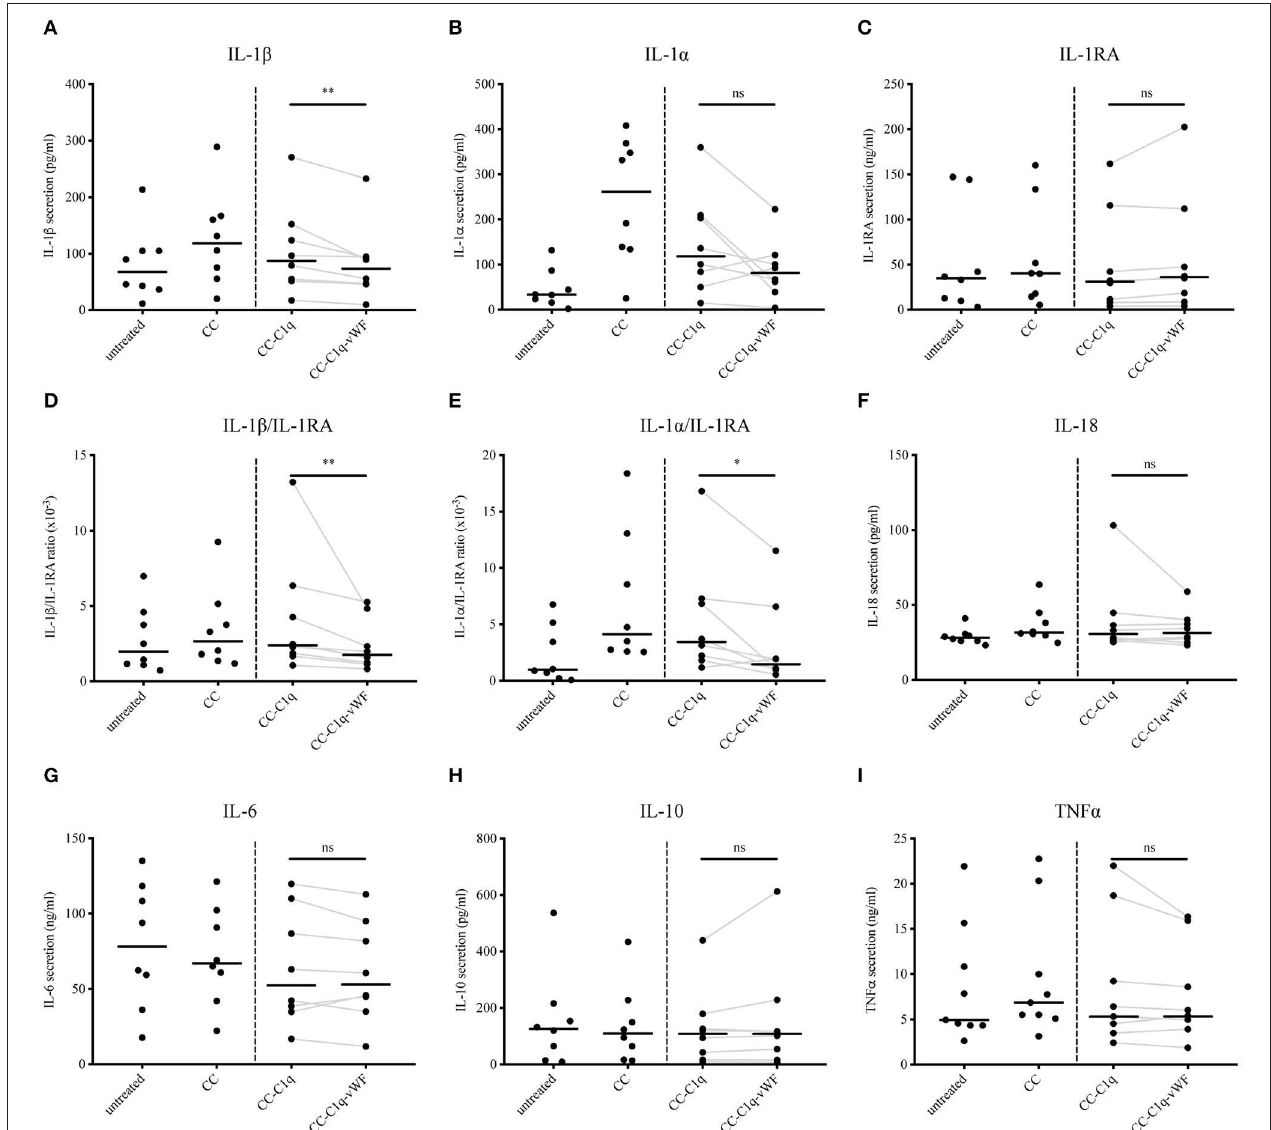
FIGURE 4 | CC-C1q-vWF complexes diminish LPS-induced IL-1 secretion of HMDMs. LPS-induced HMDMs were kept untreated or treated with CC, CC-C1q, or CC-C1q-vWF complexes for 18h. Supernatants were analyzed by ELISA for cytokine secretion. Data show median cytokine concentrations of (A) IL-1 β , (B) IL-1 α , (C) IL-1RA, (F) IL-18, (G) IL-6, (H) IL-10, and (I) TNF α levels or median ratios of (D) IL-1 β /IL-1RA and (E) IL-1 α /IL-1RA of pooled donors. Data points represent independent experiments analyzing eight different healthy donors used to obtain HMDMs (Wilcoxon matched pairs signed rank test, * p < 0.05; ** p < 0.01; ns, not